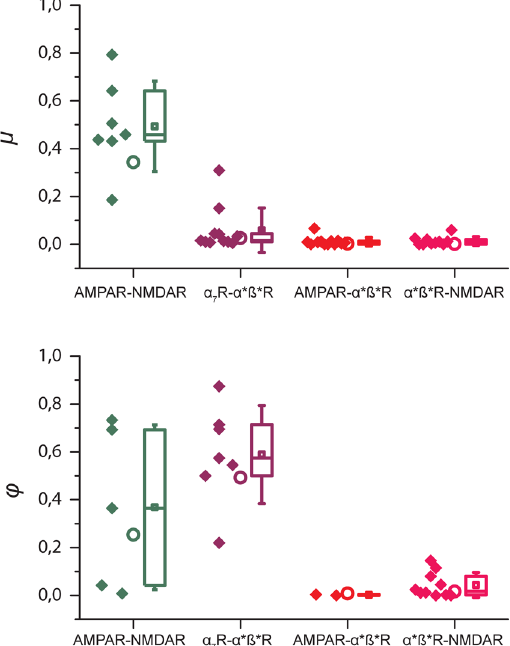
Figure 5. Bar graphs summarizing the values of µ (top) and ϕ (bottom). The upper graphs illustrate the values of µ , the fraction of events with a fast rise and a slow decay detected in the lower right quadrant in the initial two-receptor situation and eliminated when an appropriate antagonist blocks the slower receptor (D-APV for the NMDAR-AMPAR couple, DHßE for the α 7 - α * β * nAChR couple, NBQX for the AMPAR- α * β * nAChR couple, D-APV for the α * β * nAChR-NMDAR couple). The lower graphs illustrate the values of ϕ , the fraction of fast-rising fast-decaying events which appeared in the same set of experiments as in the upper graphs when the appropriate antagonist blocked the slower receptor. Each data set represents the value from individual experiments (symbols on the left) and a whisker plot (on the right) indicating the mean of the values for all the experiments (large symbol), the median (horizontal line) the 25 and 75 percentiles (extension of the box). The whiskers represent one standard deviation around the mean value. The circles represent the value of µ and ϕ obtained with the pooled events from the data illustrated in Fig.